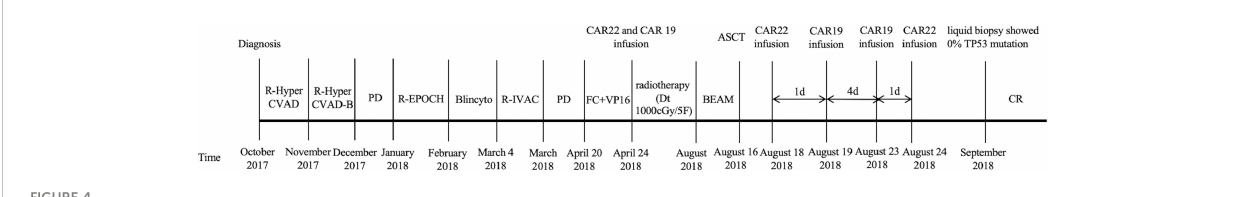
FIGURE 4 The timeline of the clinical treatment and disease